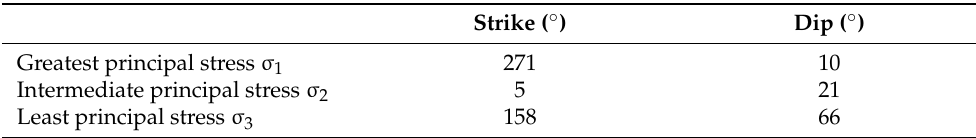
Table 2. Tectonic stress field